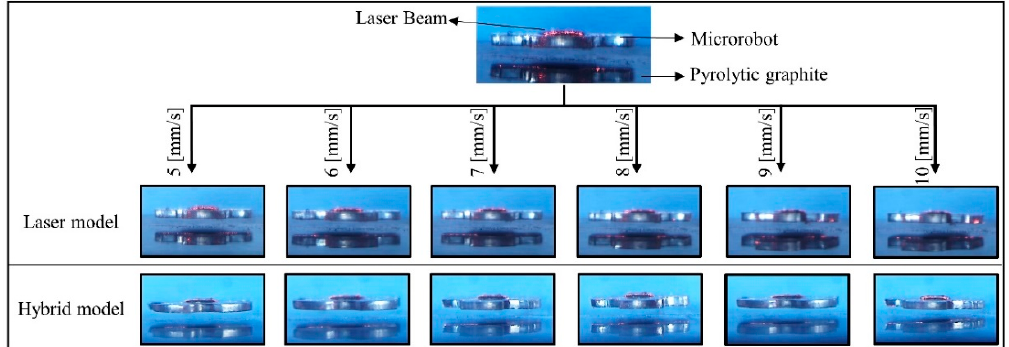
Figure 15. The images taken by the experimental data of the laser feedback and the hybrid model controllers at six different speeds in the range of 5–10 mm/s. In order to make the laser marker visible, the experimental images of the microrobot are presented in isometric view.